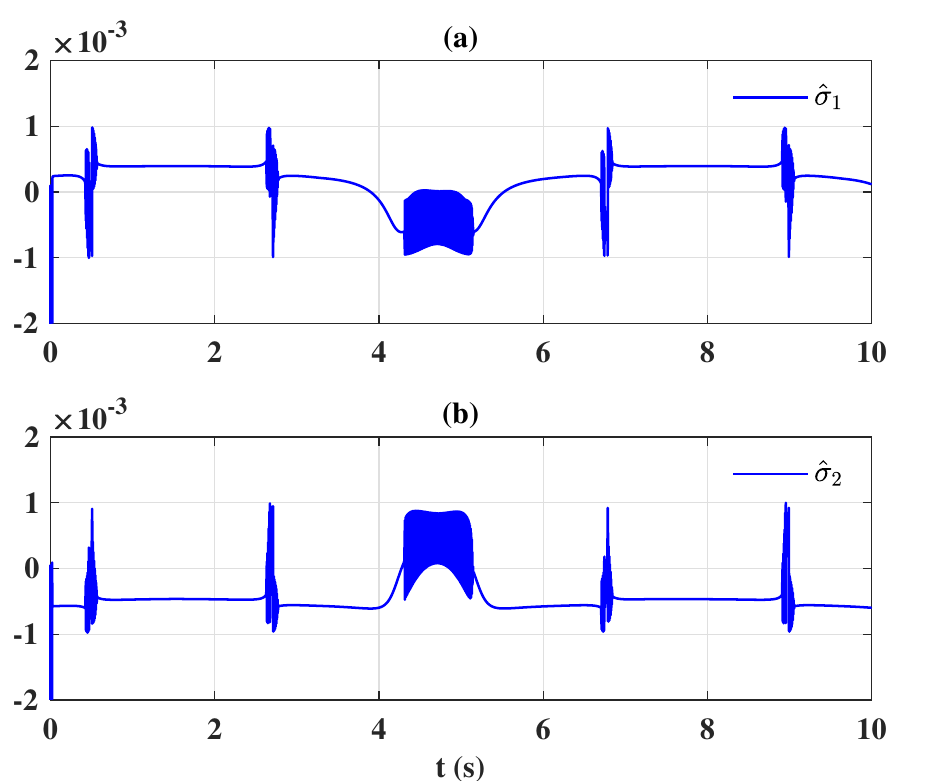
Figure 3. Time history of sliding surfaces ( a ) ˆ σ 1 and ( b ) ˆ σ 2